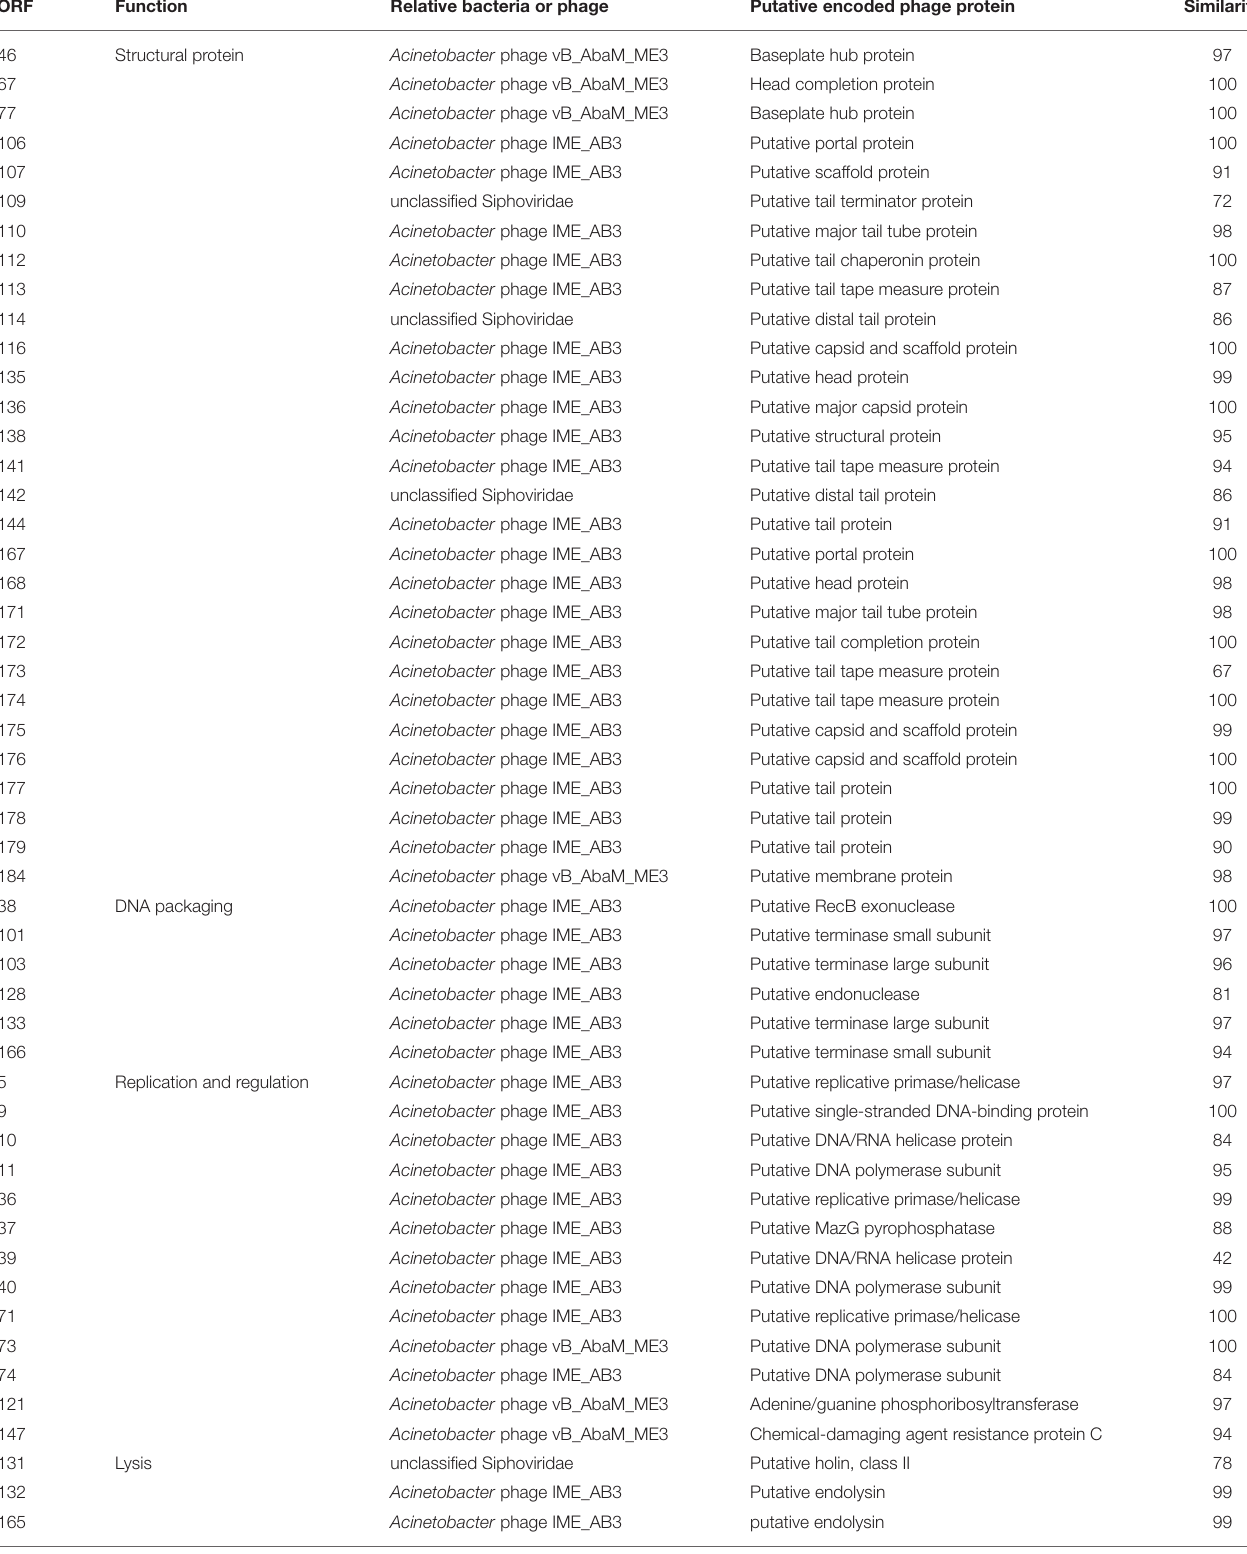
TABLE 3 | Functional annotation of putative ORFs found in PBAB25. ORF Function